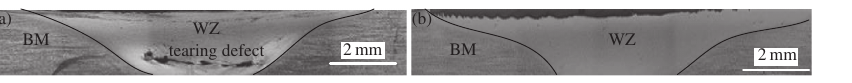
Figure 2: Cross-section morphologies of 2mm thick joints: (a) 375 rpm/50mm/min and (b) 120